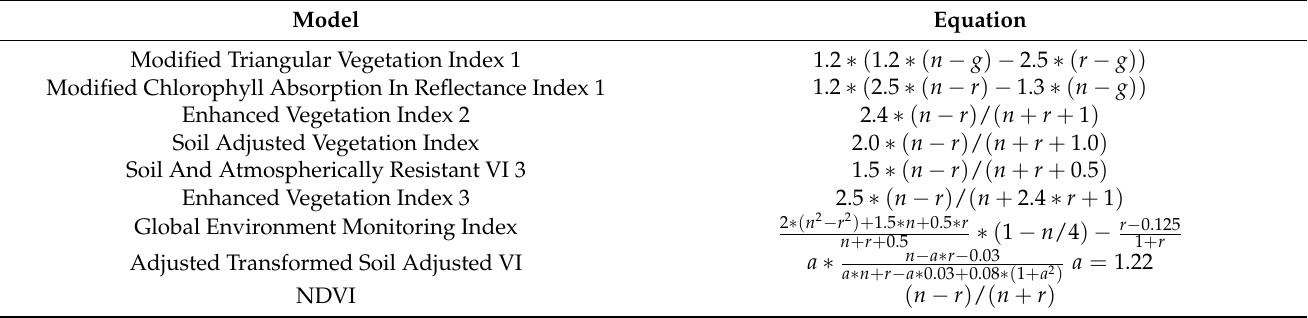
Table A1. Top optimized fixed vegetation model equations. b = ρ 0 , g = ρ 1 , r = ρ 2 , e = ρ 3 , u = ρ 4 , n = ρ 5